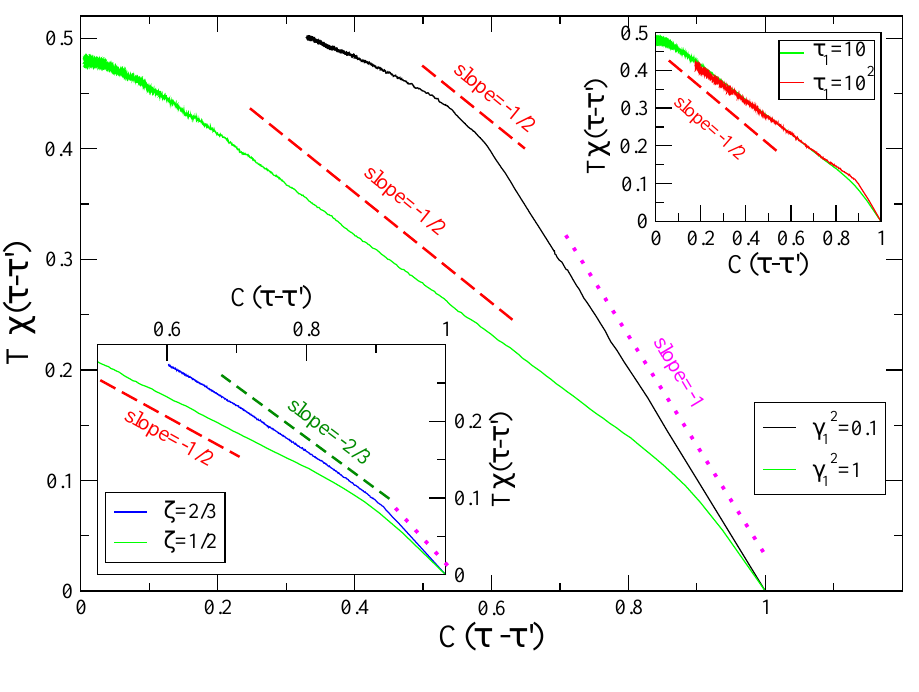
Figure 1: The fluctuation-dissipation plot of the model with multithermalized exter- nal field J . The integrated response T χ ( τ , τ (cid:48) ) is plotted against the autocorrelation i function C ( τ , τ (cid:48) ) for a system of N = 2 10 spins with random bimodal coupling con- (cid:112) (cid:113) γ = ± 1 / 2 N . The external fields are bimodal variables ± . The temper- stants J ij 1 ature of the spins is T = 1 / 2 and that of the magnetic field is is T (cid:48) = T /ζ , with ζ = 1 / 2. Curves averaged over 8 − 19 · 10 3 realisations, for the various cases (in the main figure and in the insets). The perturbing field for the computation of χ is set = 10 for all the curves. τ (cid:48) is set to H = 0.1. The timescale of the slow bath is τ 1 to τ (cid:48) = 1500 in order to be in the stationary state. The dotted line is the equilib- rium slope − 1 while the dashed red one are the expected slope − 1 / 2. Lower inset: comparison, for H = 1, between the case with ζ = 1 / 2 (green curve, same as in the main figure) and ζ = 2 / 3 (blue curve). For the latter it is τ (cid:48) = 600. Upper inset: = 10 (green curve, comparison, for H = 1 and ζ = 1 / 2, between the case with τ 1 = 100. For the latter it is τ (cid:48) = same as in the main figure) and with τ 1